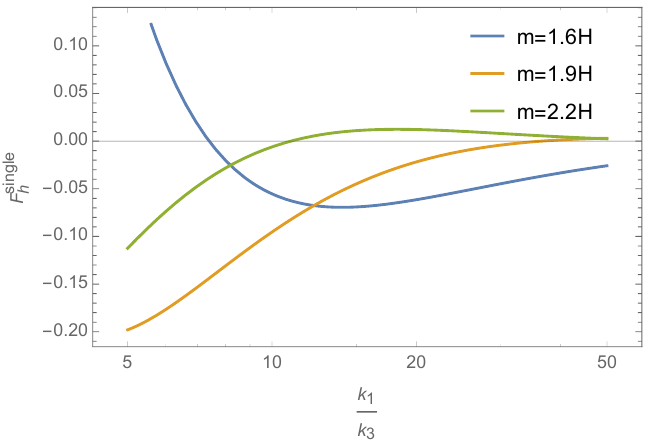
(2.18) for di(cid:11)erent masses in Goldstone h